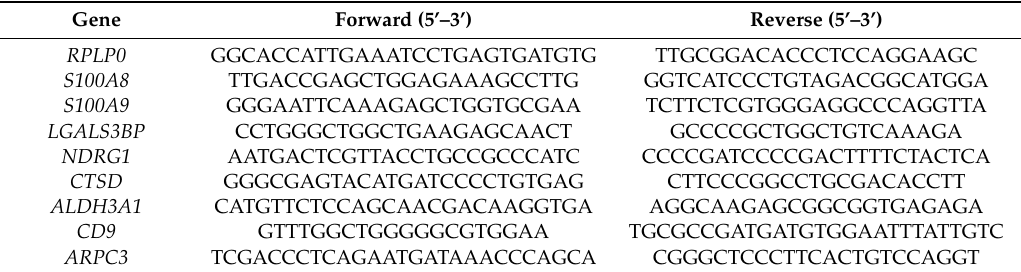
Table 1. Primer sequences for qPCR analysis of selected target genes identified by quantitative proteomics